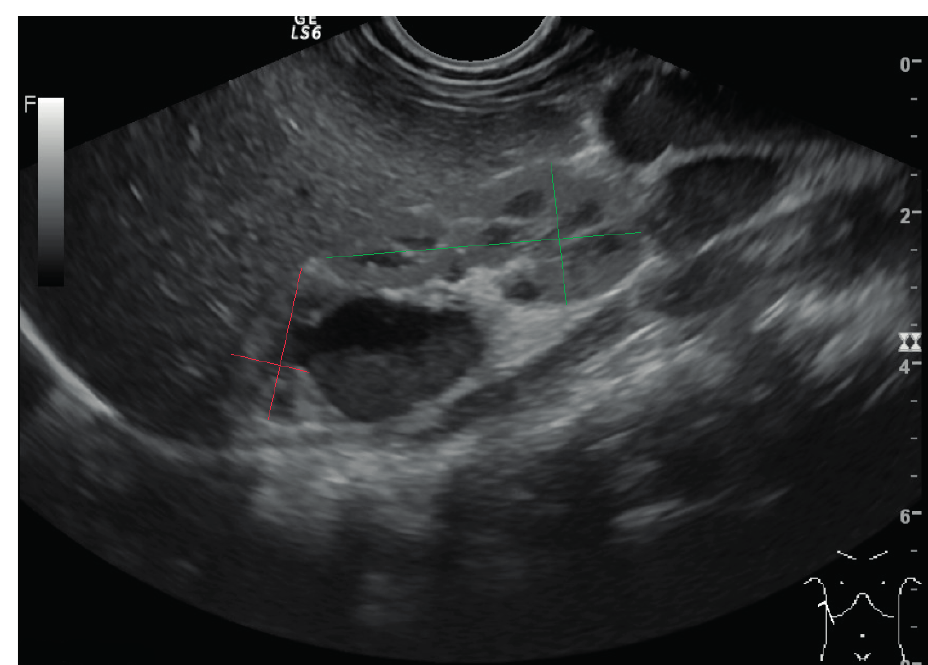
Fig. 2. Ultrasound image of the same patient. duplex system with dilated Up renal pelvis. measurement of upper and lower segments was per- formed and compared with scintigraphy findings in order to refine the determination of the extent of both